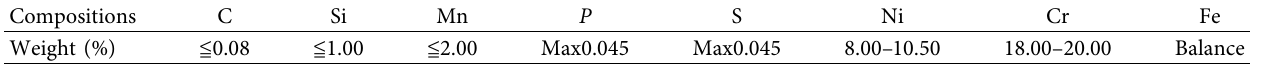
Table 1: SUS304’s chemical compositions (JIS standard).